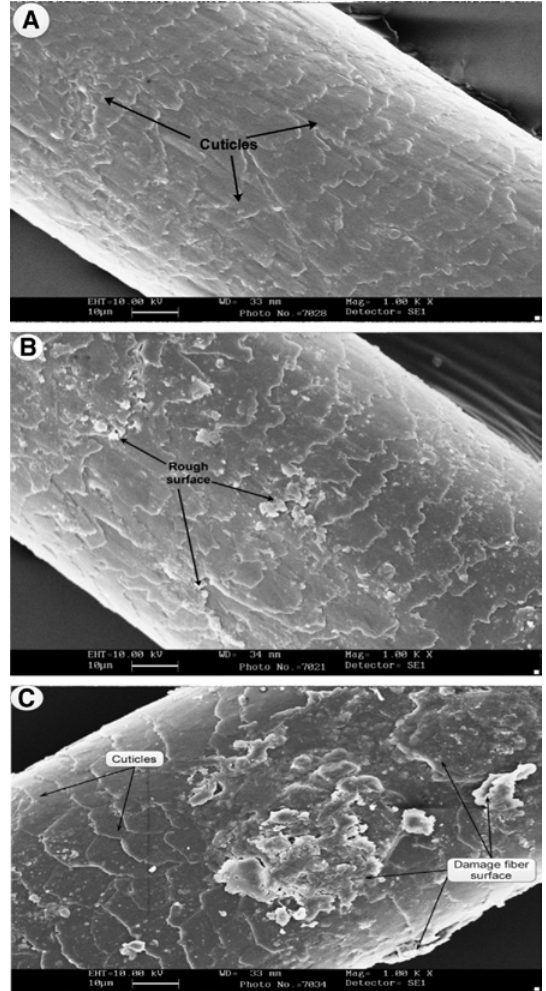
Figure 9: (A) SEM micrographs of untreated HF, (B) SEM micro- graphs of 0.25 N alkali-treated HF, and (C) SEM micrographs of 0.5 N alkali-treated